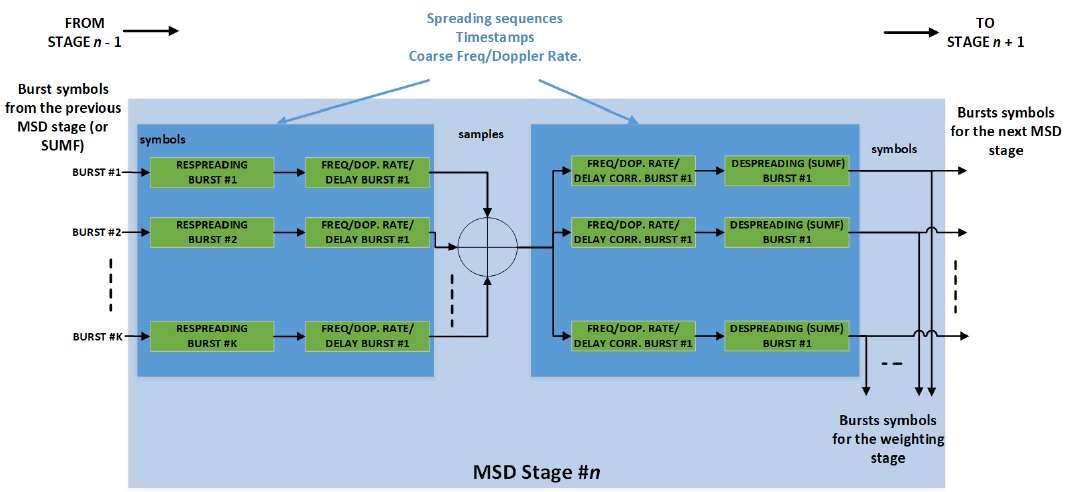
Figure 9. Single block of the MSD, as reported previously in [2].